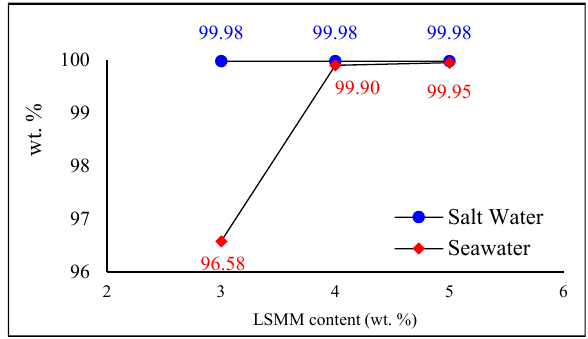
Figure 9. Salt rejection